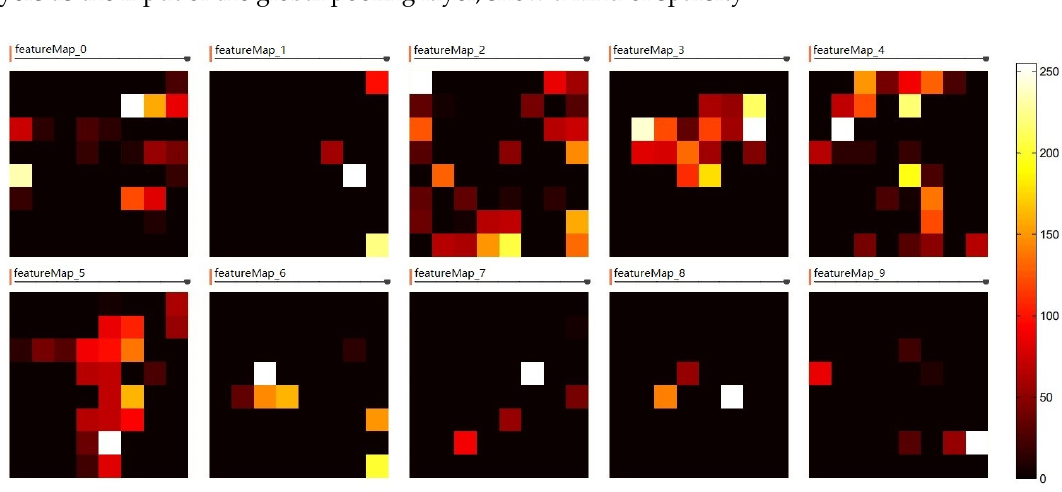
Figure 3. Feature-maps fed into the global average pool in DenseNet. Each feature-map has 64 tiny blocks (features); the brighter the block, more activation the feature has. The feature-maps show a kind of sparsity.